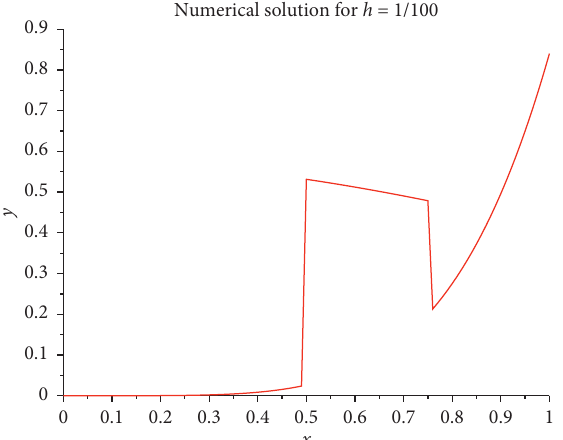
Figure 5: Numerical solution ρ ( 1/1000 ) ( x ) for h � ( 1/1000 ) .